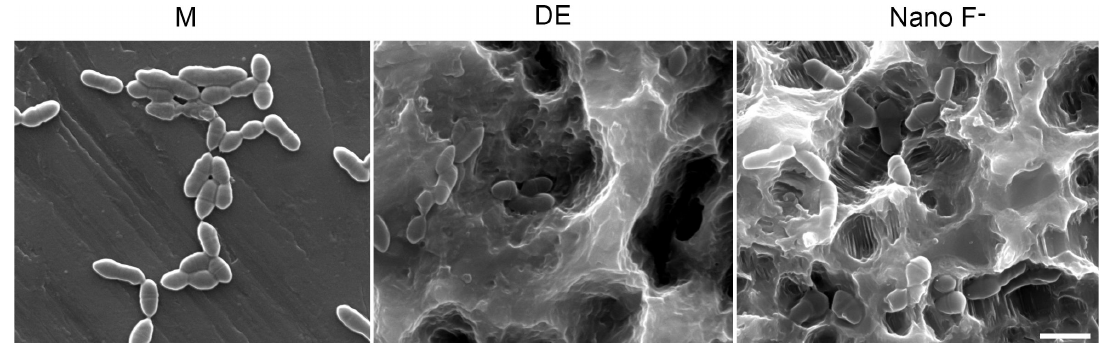
Figure 4. Scanning electron microscopy of the bacteria on the different analyzed surfaces M (A), DE (B) and Nano F - (C). Bar = 1μm.